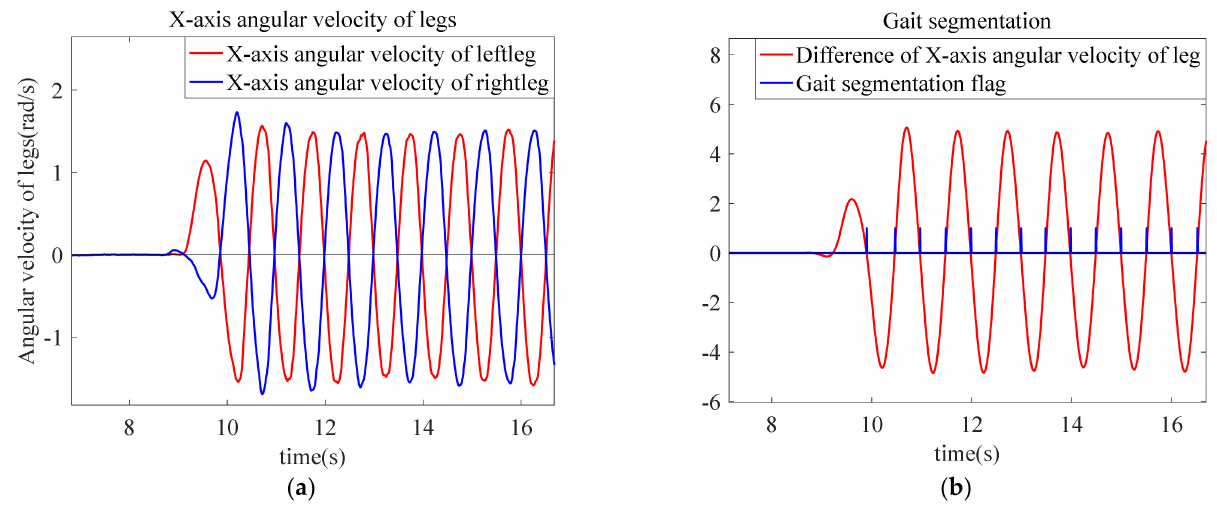
Figure 4. Digram of angular velocity of legs and gait segmentation: ( a ) X -axis angular velocity of legs; and ( b ) gait